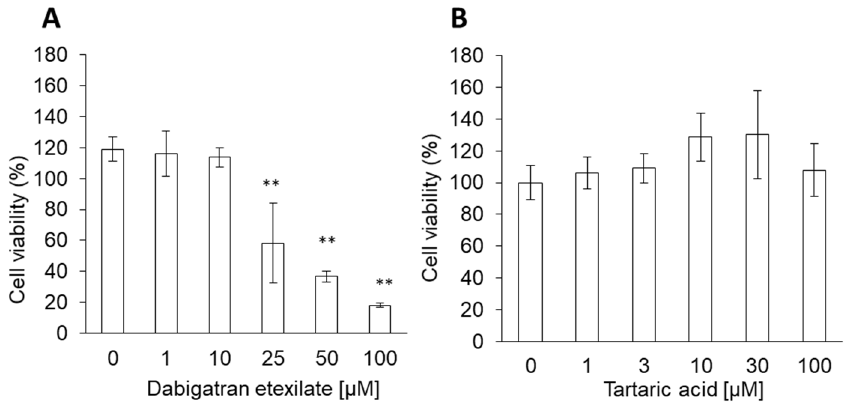
Figure 1. The cytotoxicity effect of ( A ) dabigatran etexilate and ( B ) tartaric acid. RGM1 cells were exposed to culture medium containing several concentrations of dabigatran etexilate or tartaric acid for 24 h, then a cell viability assay was performed. Data are expressed as means ± SD (n = 6). ** p < 0.01.